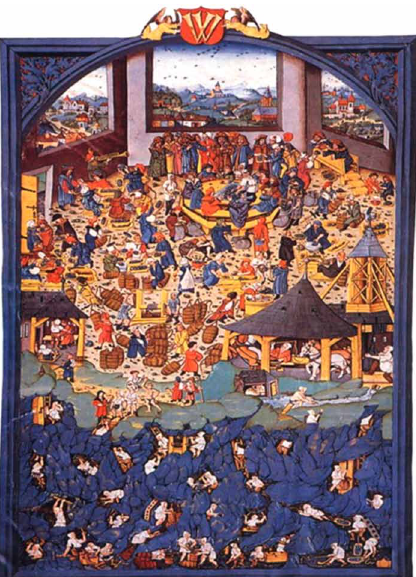
Fig. 2. Introductory page of the Kutnohorský mass songbook